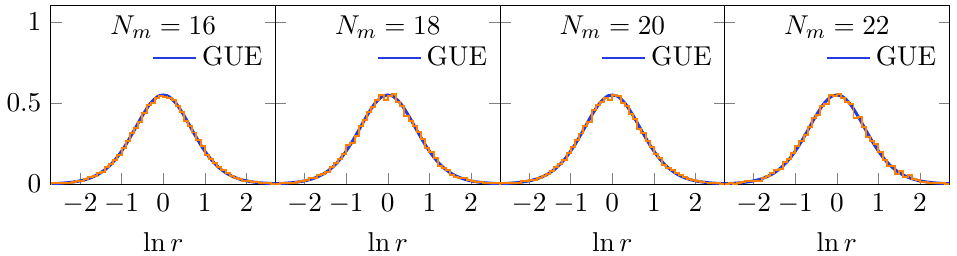
Figure 1 . Statistical distribution of the ratio r of two consecutive level spacings for the N = 0 SYK model with q = 6. The number of realizations used for averaging was 10 3 for N m = 16, 10 2 for N m = 18 and 20, and 10 for N m = 22. The blue lines are surmises for the RMT classes in table 3.